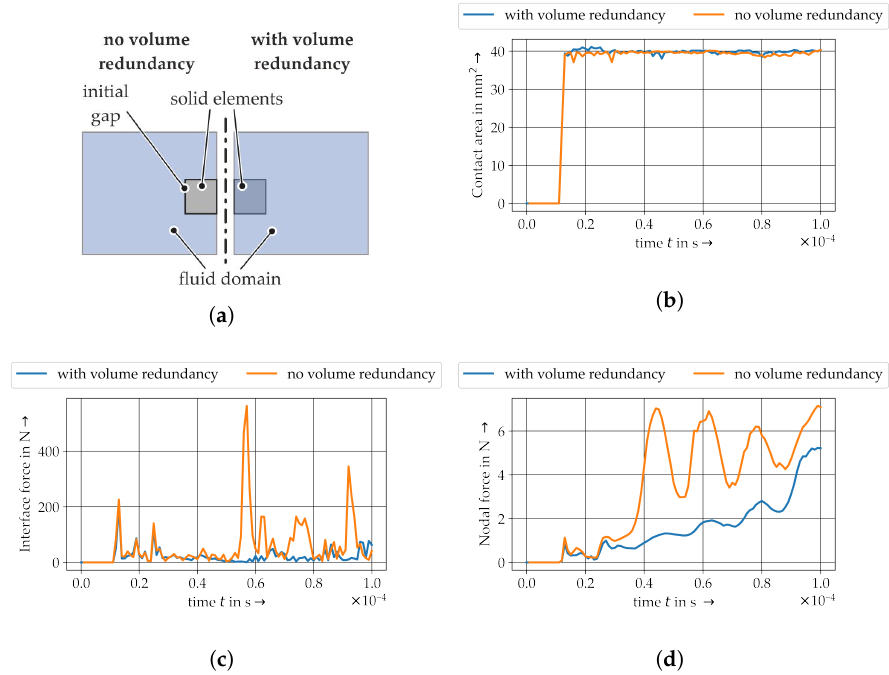
Figure 12. Investigations of the volume redundancy in ALE approach with a single structure in the collision model setup. ( a ) Principle of volume redundancy. ( b ) Contact area. ( c ) Interface forces. ( d ) Nodal